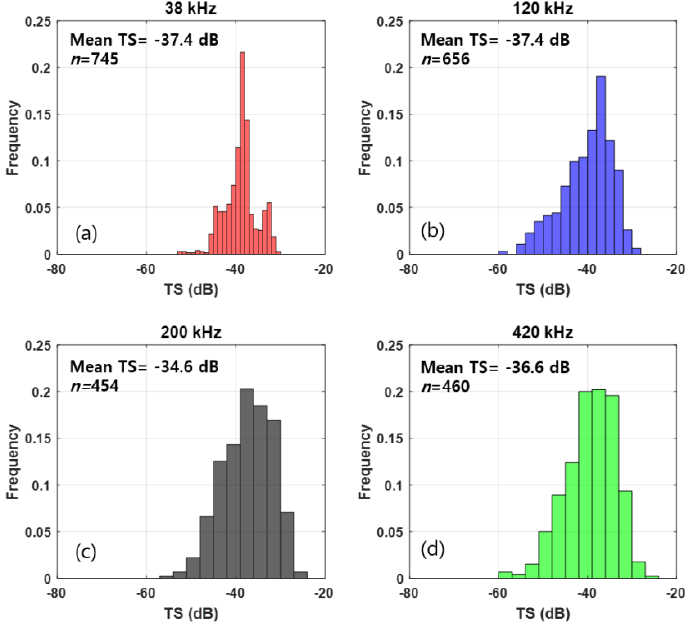
Figure 4. Representative target strength ( TS ) histograms of mullet ( FL : 35.0 cm) at ( a ) 38, ( b ) 120, ( c ) 200, and ( d ) 420 kHz. Index, n is the sample size.